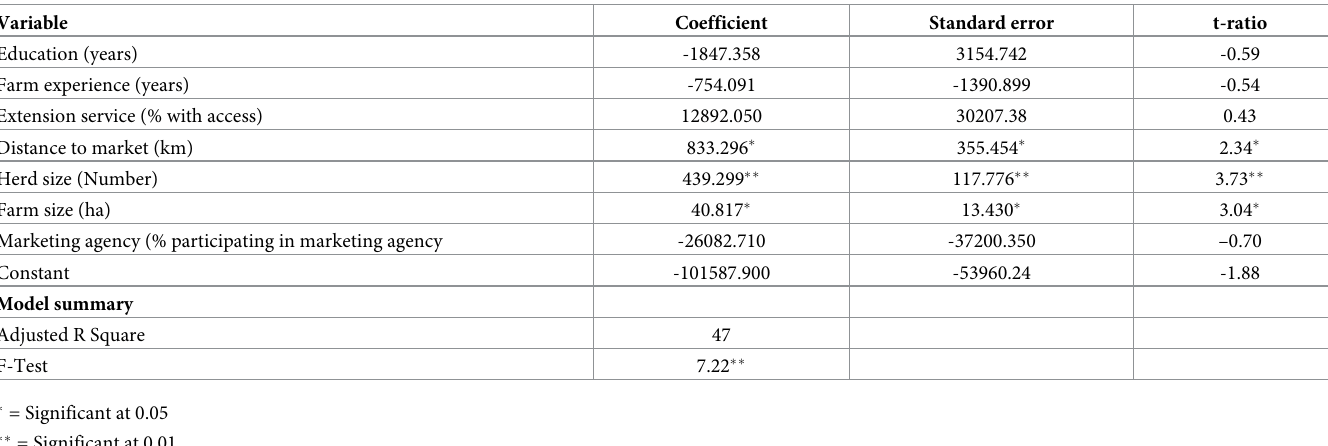
Table 3. Gross margin model estimation results (n =